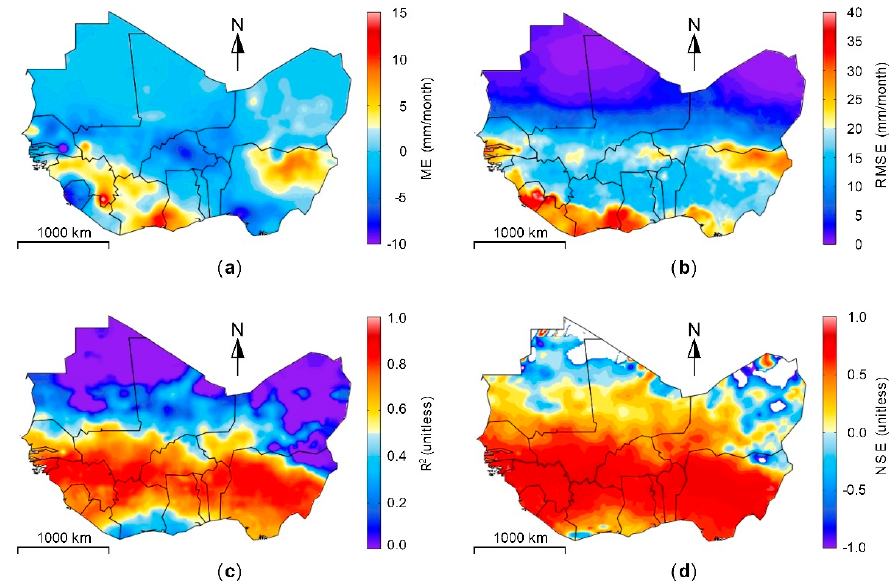
Figure 6. Validation of backcasted Noah-derived TWCC estimates. ( a ) Mean error—ME; ( b ) Root-mean-square error—RMSE; ( c ) Coefficient of determination— R 2 ; and ( d ) Nash-Sutcliffe efficiency coefficient—NSE.